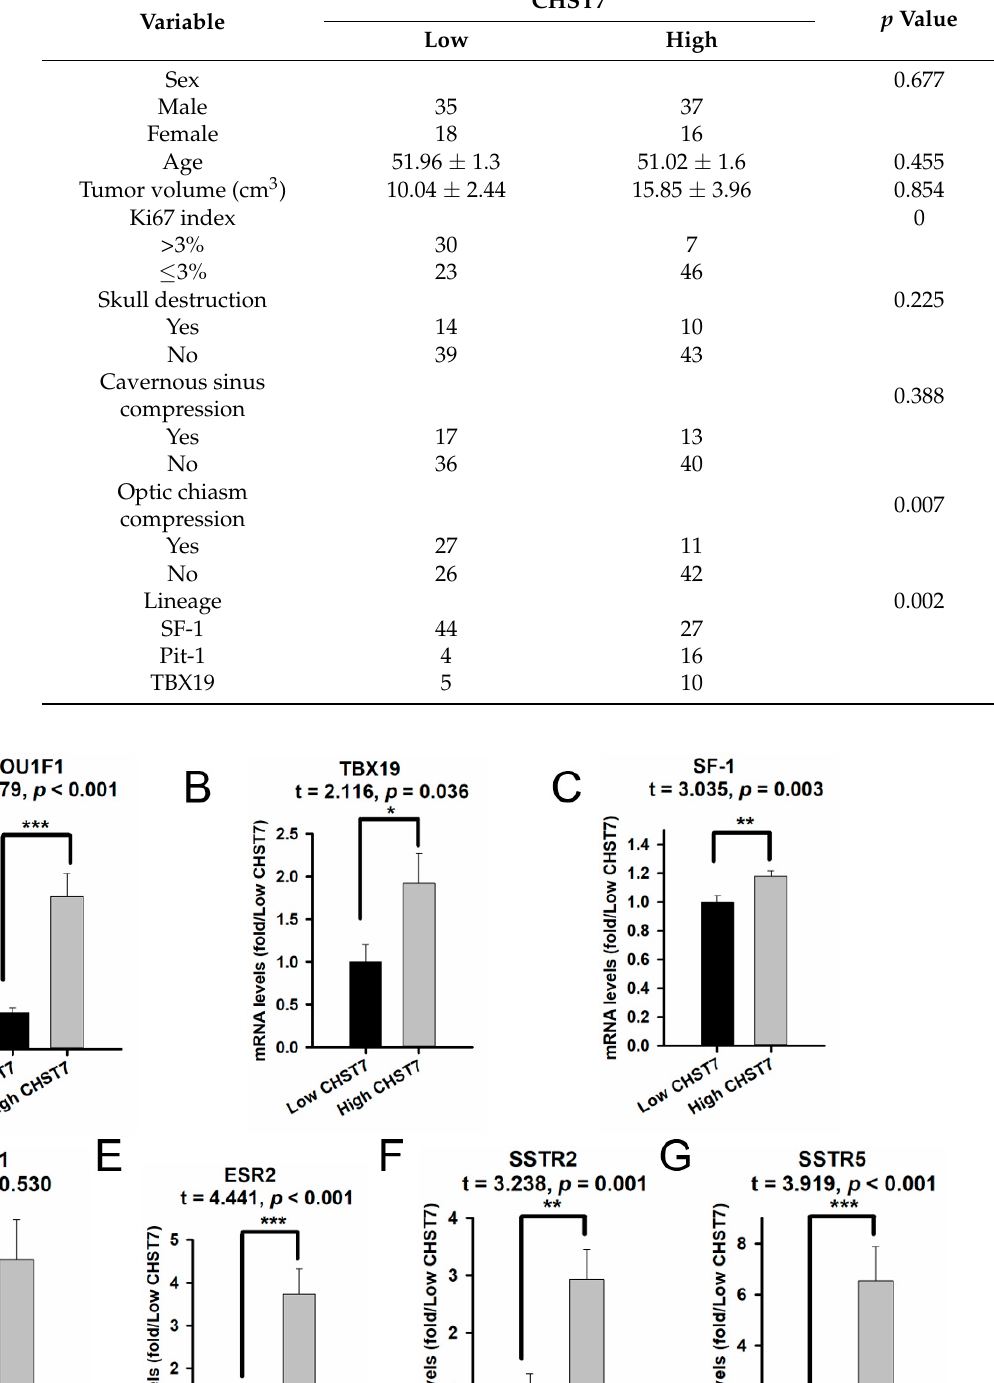
Figure 6. CHST7 is related to the tumor differentiation of PAs. ( A ) Correlation analysis of CHST7 and Pit-1 in 106 samples. ( B ) Correlation analysis of CHST7 and SSTR2 in 106 samples. ( C ) ROC curve of CHST7 for the Pit-1 lineage. ( D ) ROC curve of CHST7 for the TBX19 lineage. ( E ) ROC curve of CHST7 for the SF-1 lineage.